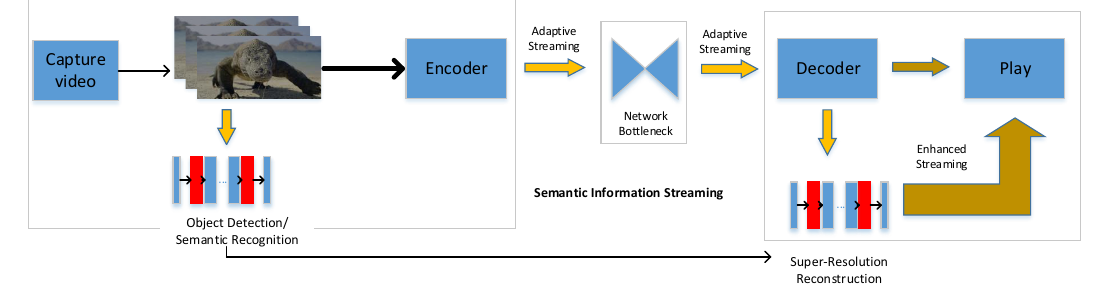
Figure 1. The idea of SASRT over